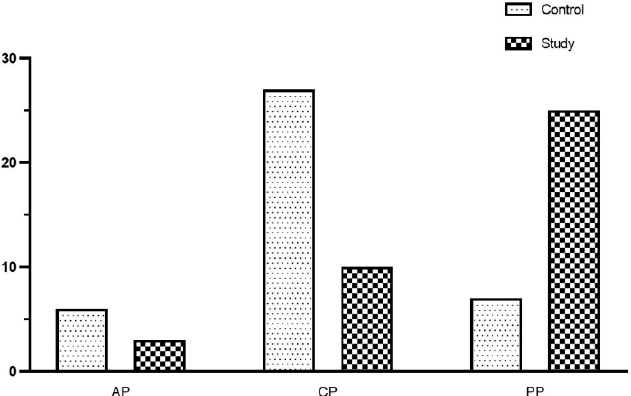
Figure 8. The position of the condyle between the study group and the control group (sagittal view). AP: anterior position, CP: central position, PP: posterior position. The statistical results: x 2 = 19.198, p = 0.000. Table 6. The comparison of joint space between the left and right TMJs in sleep bruxers. Variables